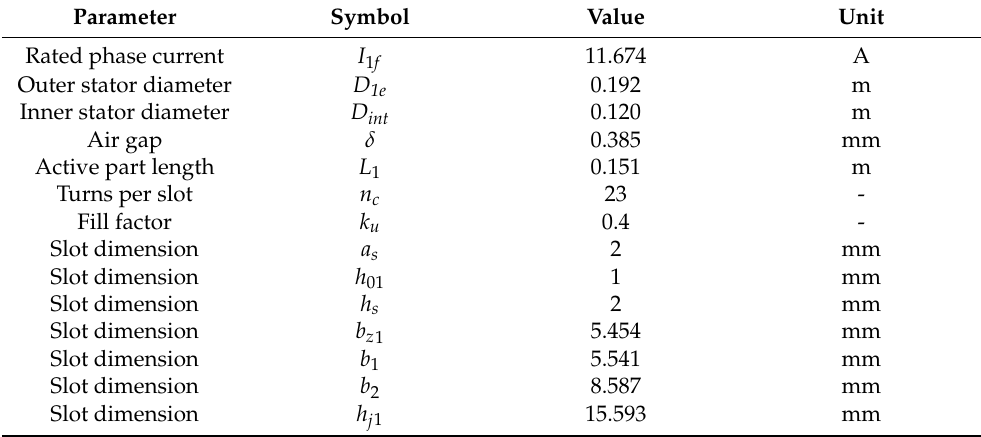
Table 2. Output data of the stator